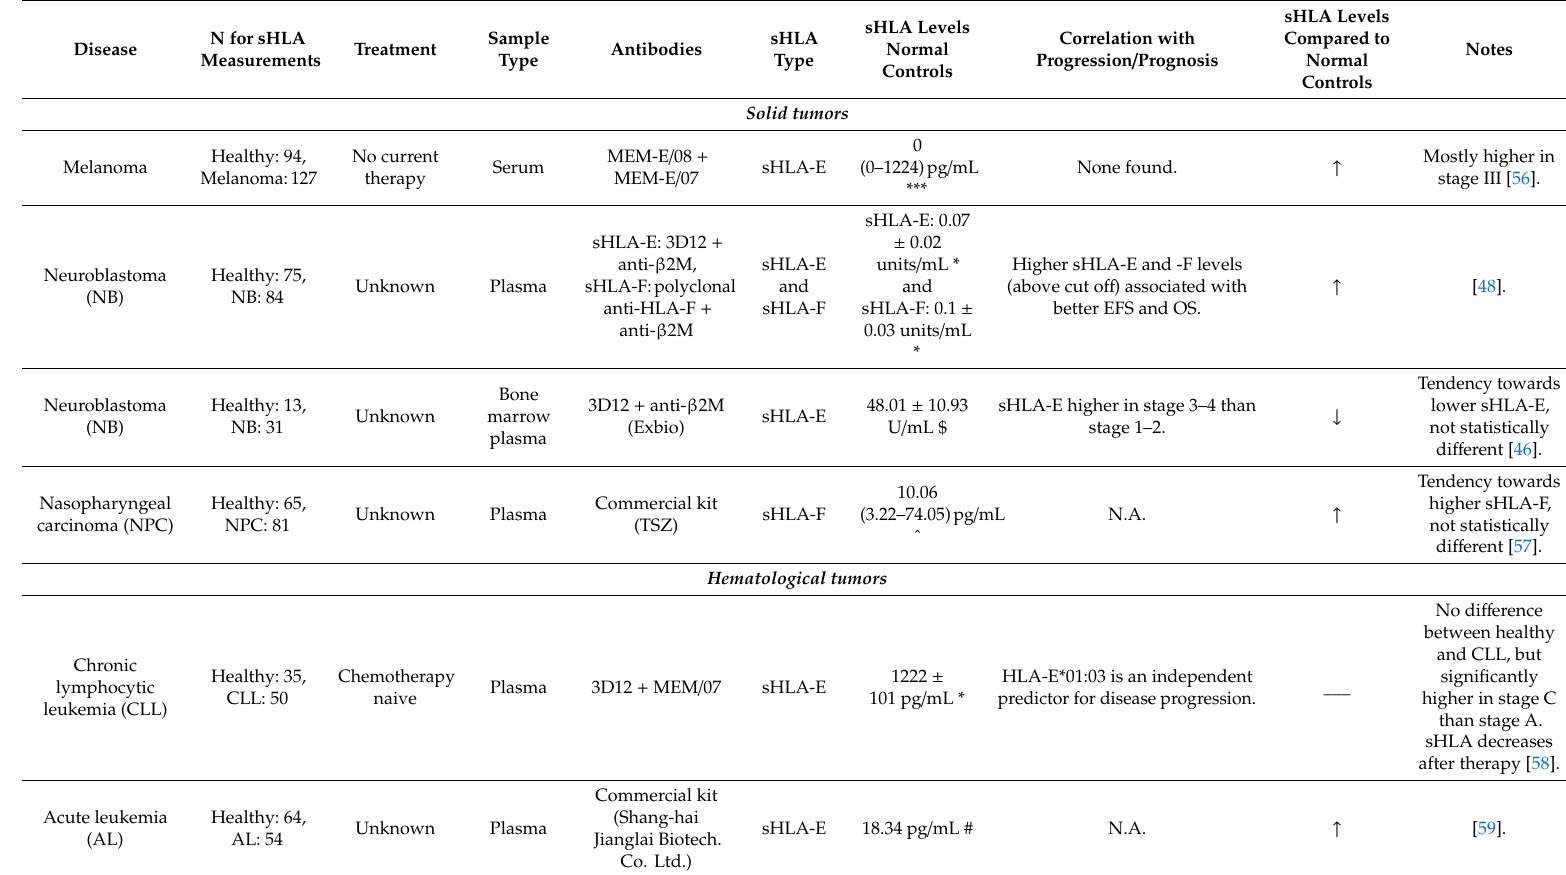
Table 3. Soluble HLA-E and HLA-F Molecules in Malignancy . Levels of soluble HLA-E and -F molecules in various solid and hematological tumors. All studies measured sHLA levels by ELISA, unless indicated otherwise under Notes. * = mean ± SD, *** = median (range), # = mean, $ = median ± SE, and ˆ = mean